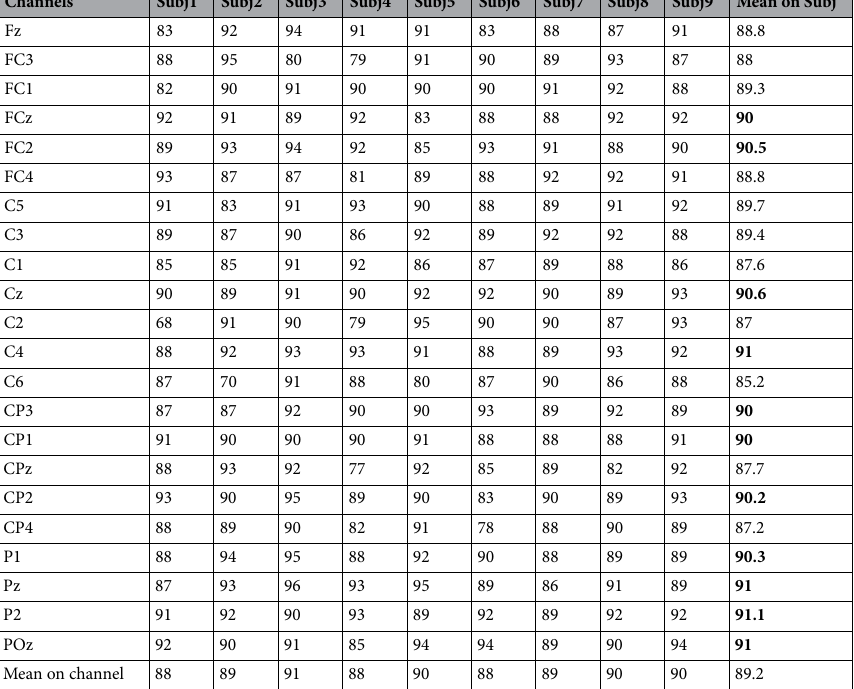
Table 3. Accuracy of customized EEG-CLFCNet (BO) on each electrode for 9 subjects on BCI Competition IV dataset 2a. Significant values are in [bold].